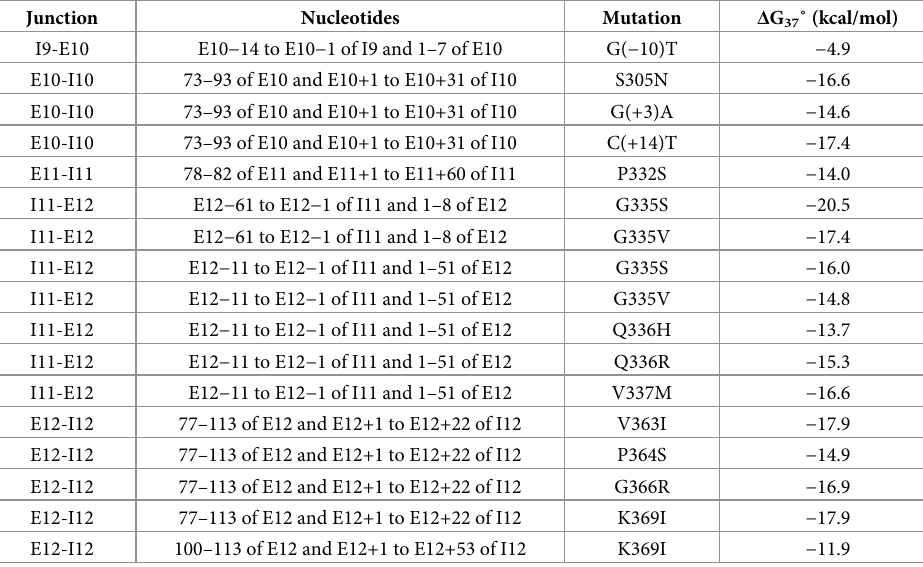
Table 2. Exon-intron junctions containing predicted mutant